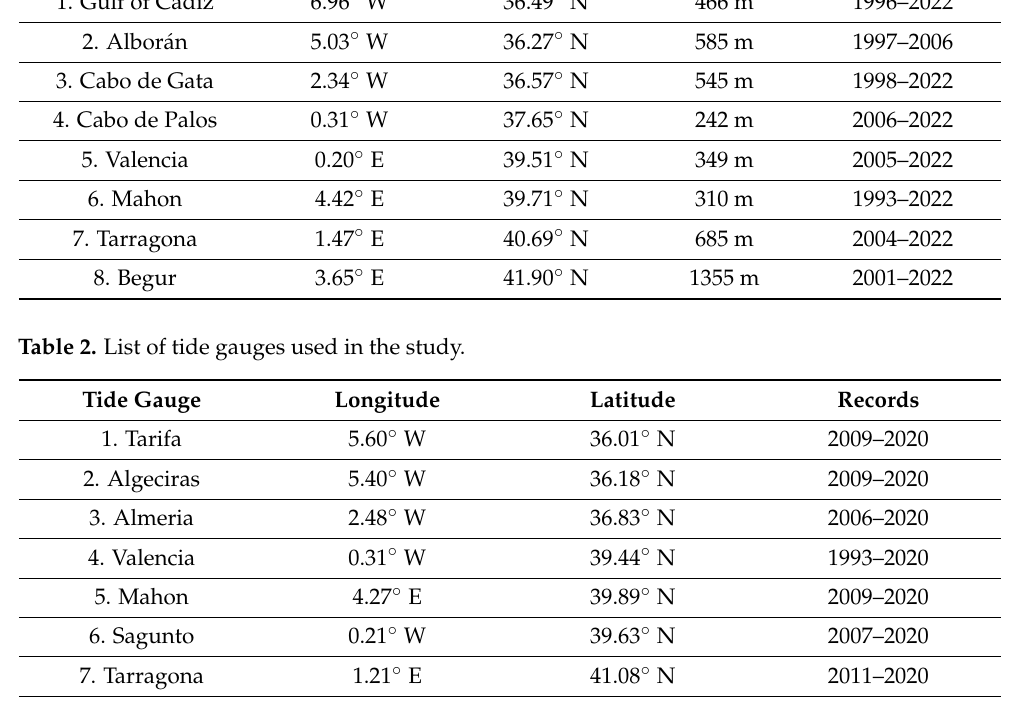
Table 1. List of buoys used in the study. Buoy Longitude Latitude Depth Records